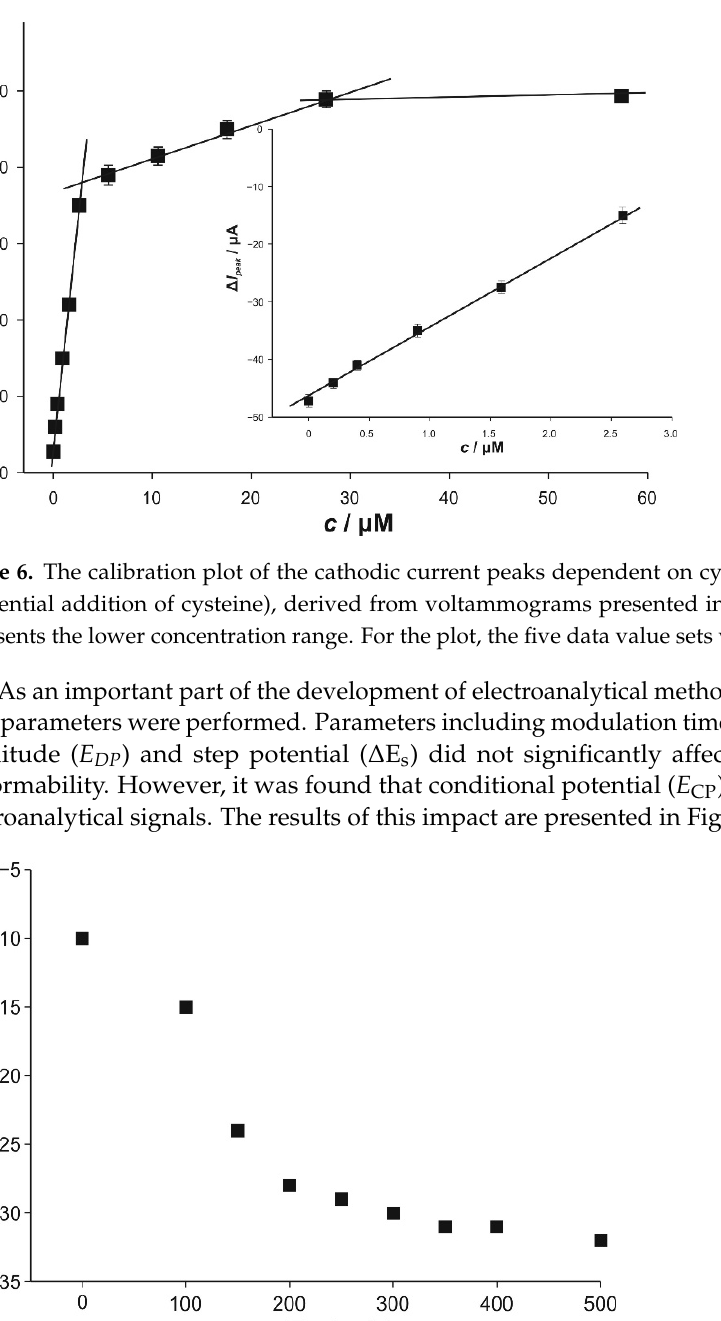
Figure 5. Differential pulse voltammograms, recorded at the CPE modified with 5% of the material, in acetate buffer at pH 5, upon successive addition of cysteine for obtaining: 0.1, 0.4, 0.9, 1.6, 2.6, 5.6, 10, 17, 27, 57, 100 and 170 μ M in an acetate buffer solution (pH 5). The dashed line represents DPV recorded without cysteine solution. Initial measurement parameters: conditional potential 25 mV, pulse amplitude 0.05 V, pulse width 0.05 s, step potential 0.01 V.